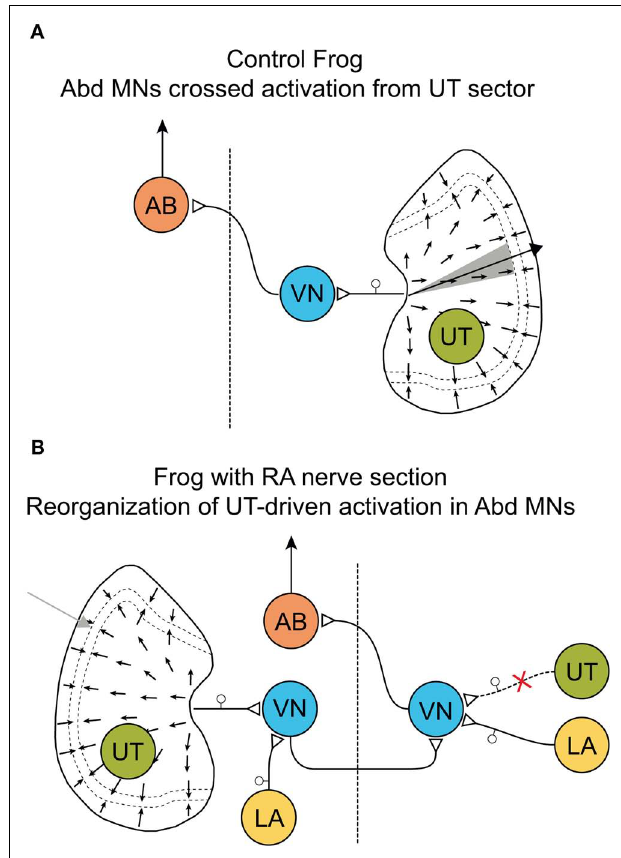
FIGURE 7 | Modification of response vectors in abducens motoneurons after labyrinthine nerve lesions. (A,B) Schematic diagram of signaling pathways before (A) and after section (B) of the anterior branch (RA) of the VIIIth nerve; afferent vestibular nerve signals during linear acceleration in contralateral (left) abducens motoneurons (AB) of controls (A) originate from a sector of hair cells (gray) on the right utricle (UT) and are mediated by neurons in the vestibular nucleus (VN) that excite contralateral AB. In chronic RA frogs (B) with a nerve section on the right side, the vestibular responses in the left AB recovered but now originate during linear acceleration from hair cells located laterally with respect to striola on the left, ipsilateral UT; after convergence with spatially inappropriate signals from the lagena (LA, yellow) in the ipsilesionalVN, these signals access contralateral AB through the default excitatory crossed projection; scheme modified and adapted from Rohregger and Dieringer